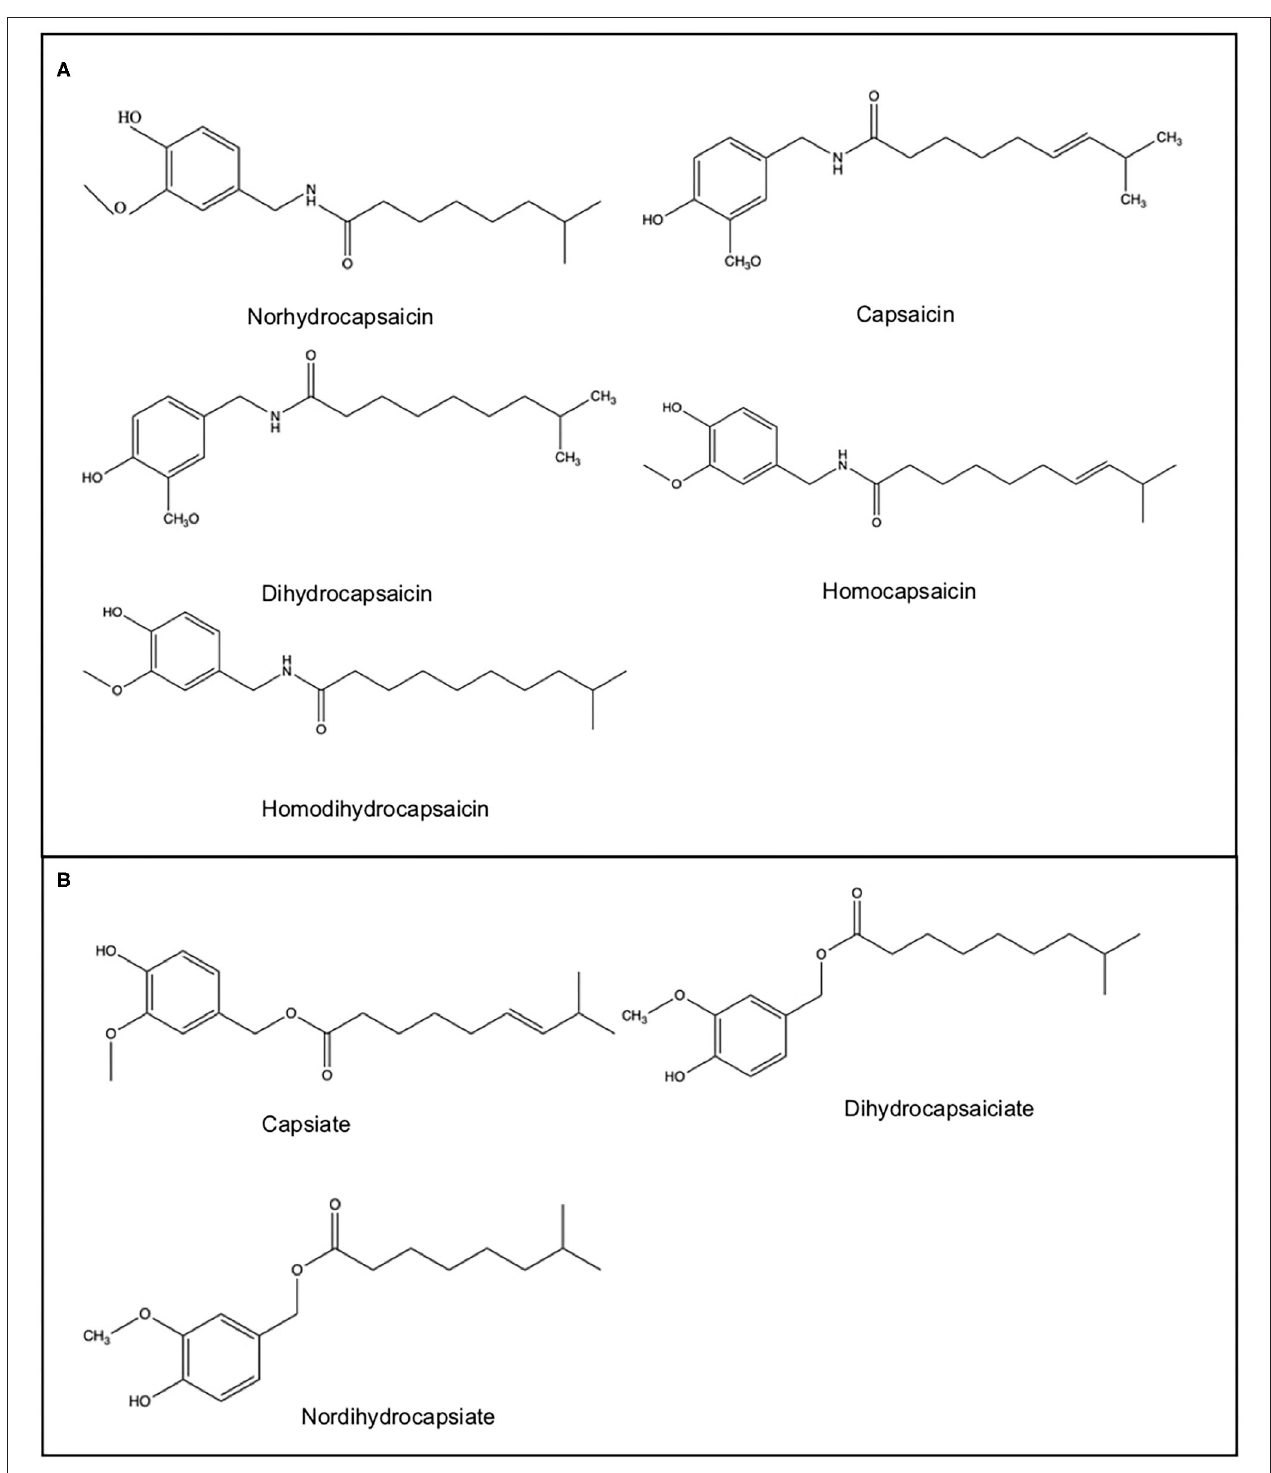
FIGURE 1 | Capsaicinoids (A) and capsinoids (B) chemical structure.